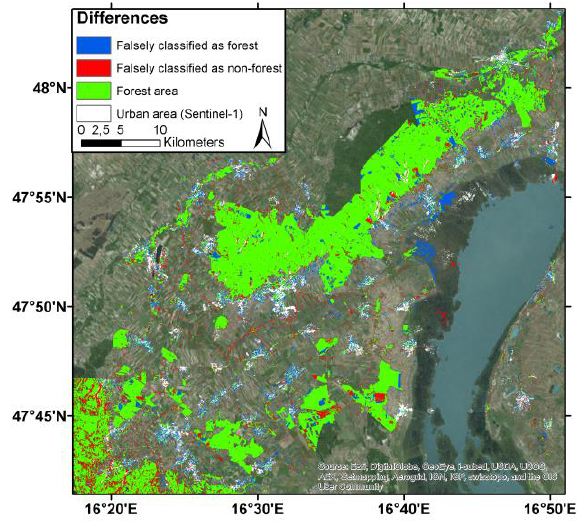
Figure 6: Differences between the ALS and Sentinel-1 (thresholding approach) forest mask for the entire region of interest overlaid on the ArcGIS Online basemap orthophoto.